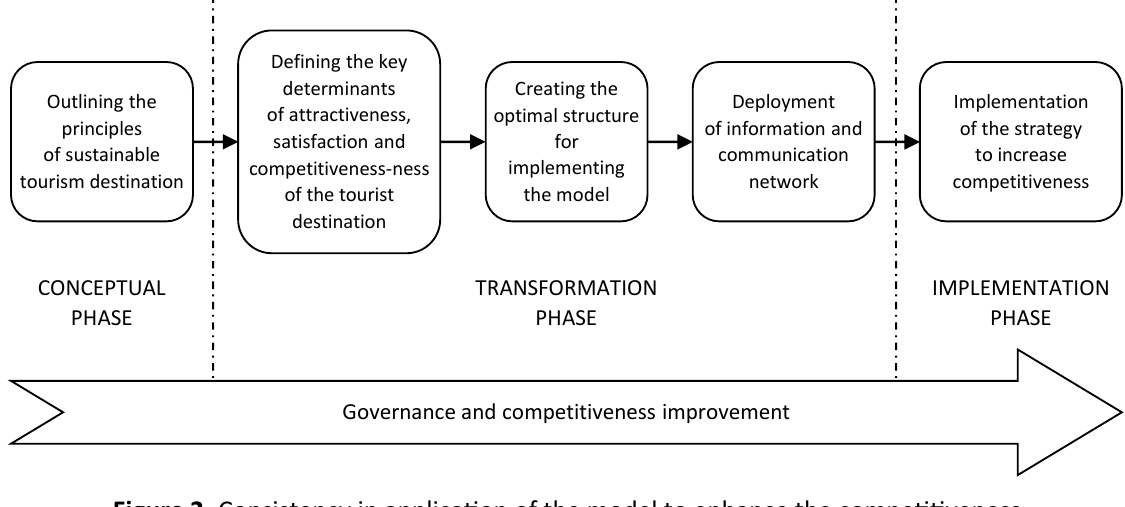
Figure 2. Consistency in application of the model to enhance the competitiveness of the tourist